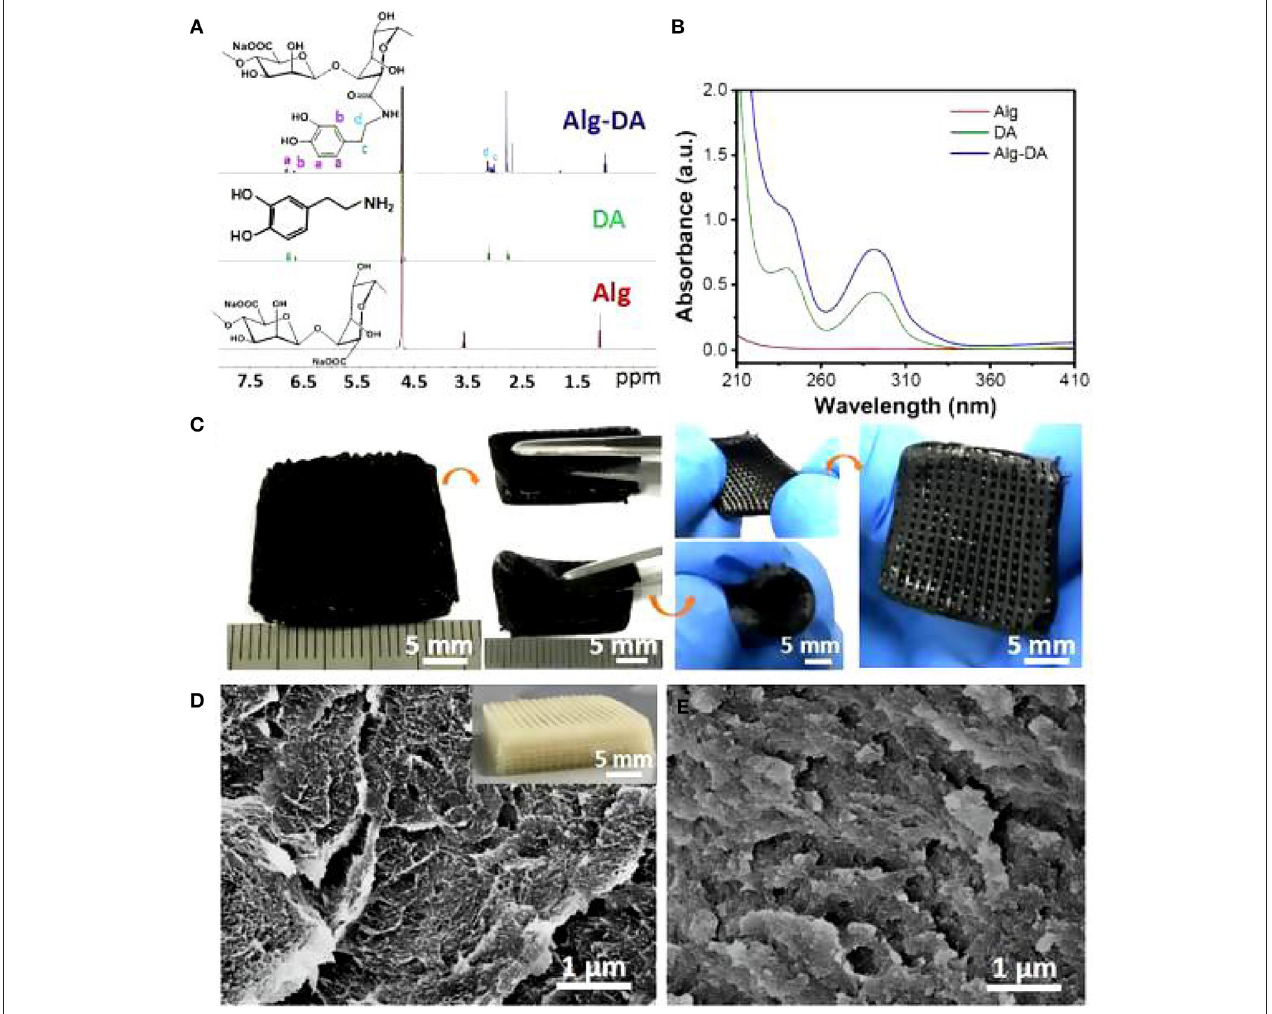
FIGURE 1 | 1H NMR spectra (A) and UV–Vis absorption (B) spectra of Alg, DA, and Alg-DA. Photographs of the 3D-printed Alg-PDA scaffold. The scaffold maintained its original structure without deformation and cracks suffering from bending, rolling, and stretching (C) . SEM images in the inside of struts of pure alginate (D) and Alg-PDA scaffolds (E)